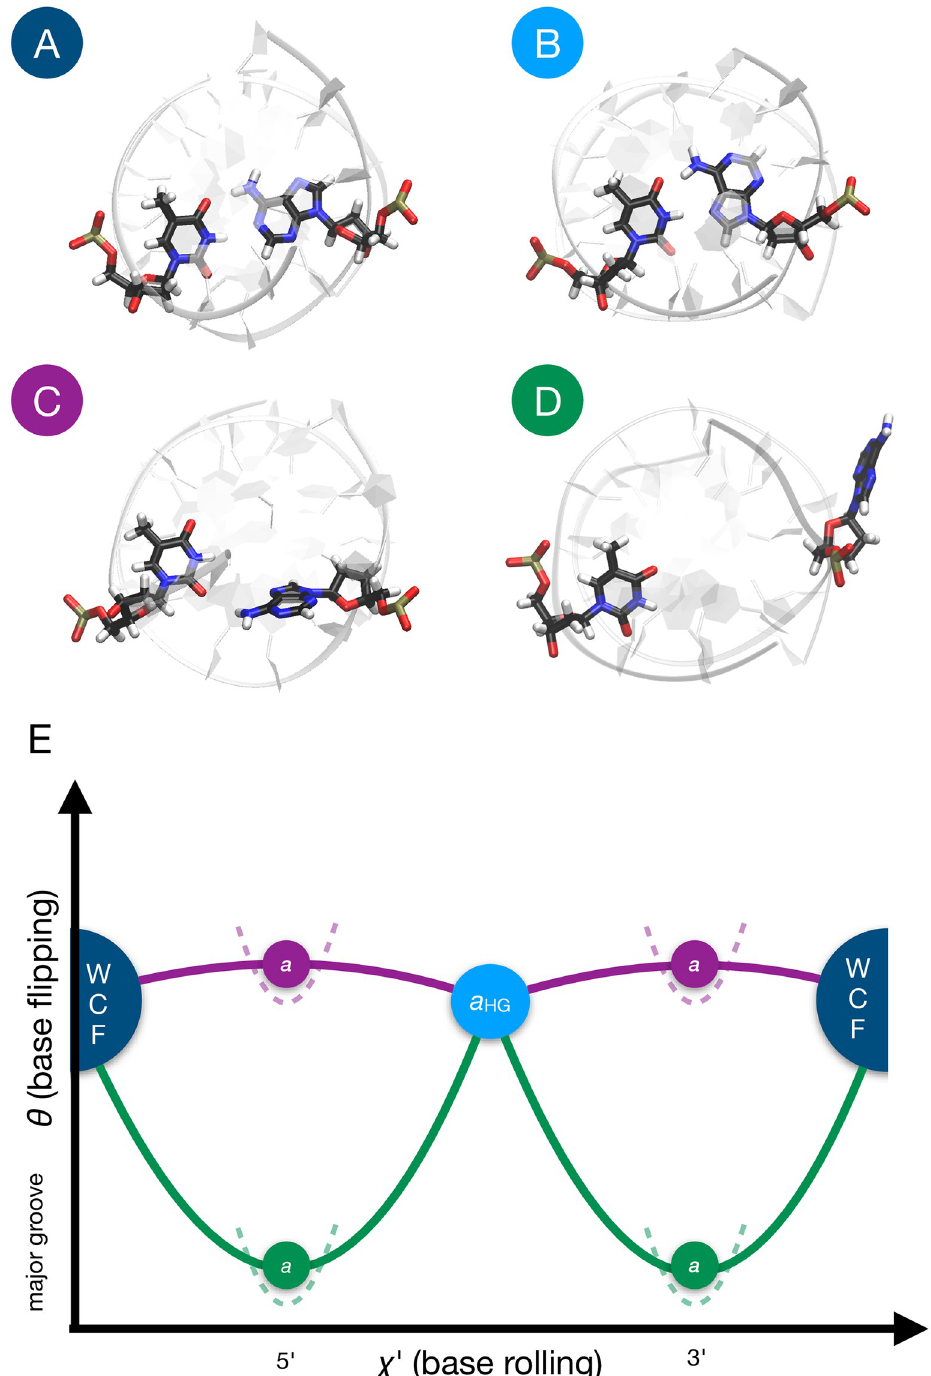
Fig 1. WCF-to-HG conformations and pathways. (A) WCF conformation of the A16 � T9 base pair in A 6 -DNA. (B) HG conformation of the same base pair. (C) Intermediate state of the WCF-to-HG transition via the inside pathway, i.e. with the rolling of A16 occurring within the double helix. (D) Intermediate state of the WCF-to-HG transition via the outside pathway. i.e. with A16 flipped out of the double helix via the major groove (E) Two cyclic paths in the space of the collective variables (CVs) χ 0 and θ , which describe the rolling and the flipping of A16, respectively. Both paths start and end at the WCF state, describing a full revolution of A16 with intermediate states in which the 6-ring of A16 points toward the 5’ or the 3’ direction of DNA. The HG state is marked by an attractor, represented by the circle labeled a HG . The purple path samples the inside mechanism, while the green path explores the outside